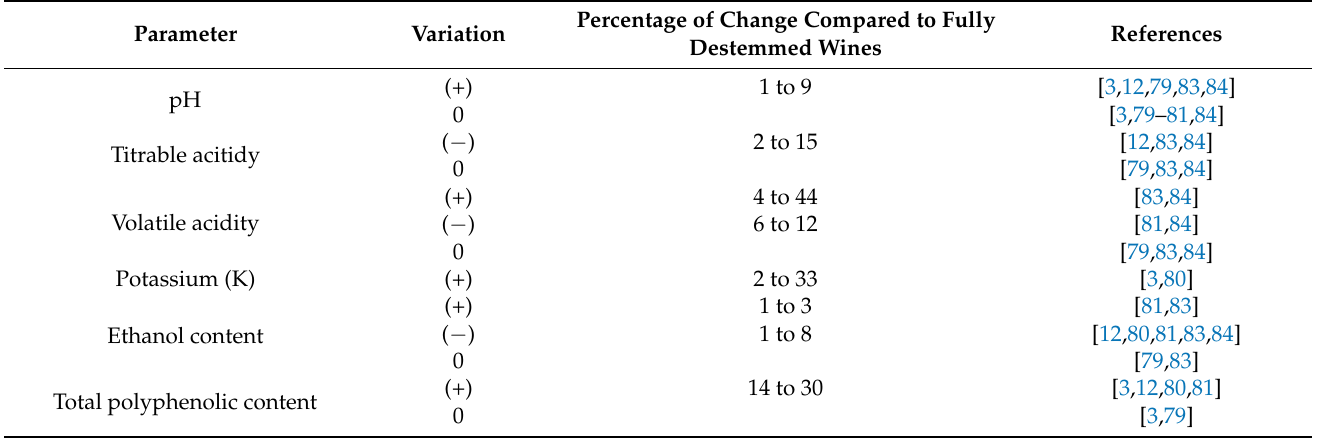
Table 23. Main effect of the use of stems or whole clusters on wines from an oenological point of view. Percentage of Change Compared to Fully Parameter Variation Destemmed Wines